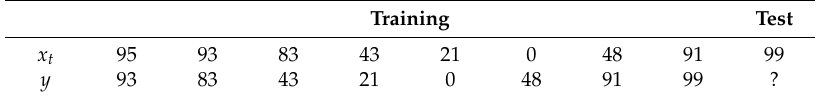
Table 2. Input and output values of a simple supervised learning function using one prior time step.